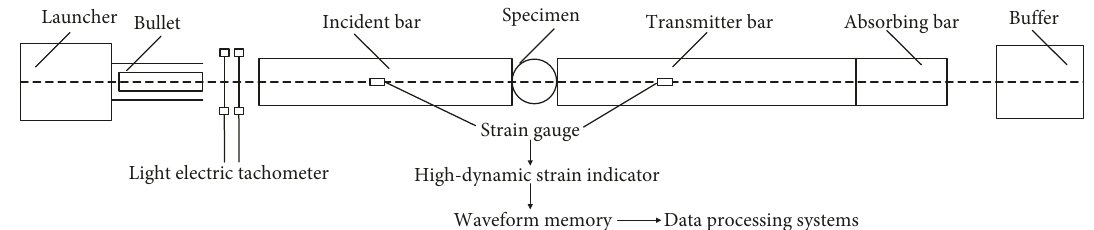
Figure 5: Schematic of the split Hopkinson pressure bar (SHPB) device.